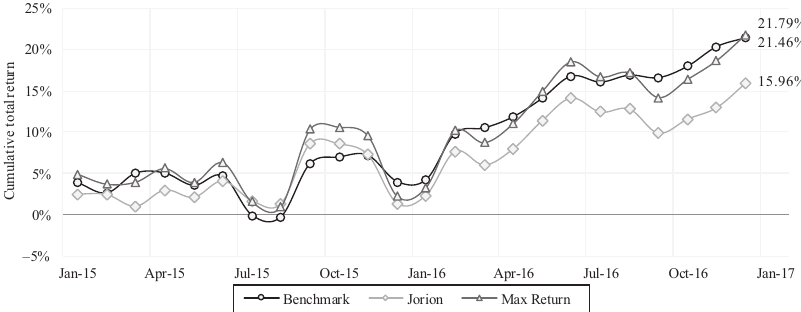
Figure 4. Cumulative return, Test 2, low volatility (70% equities